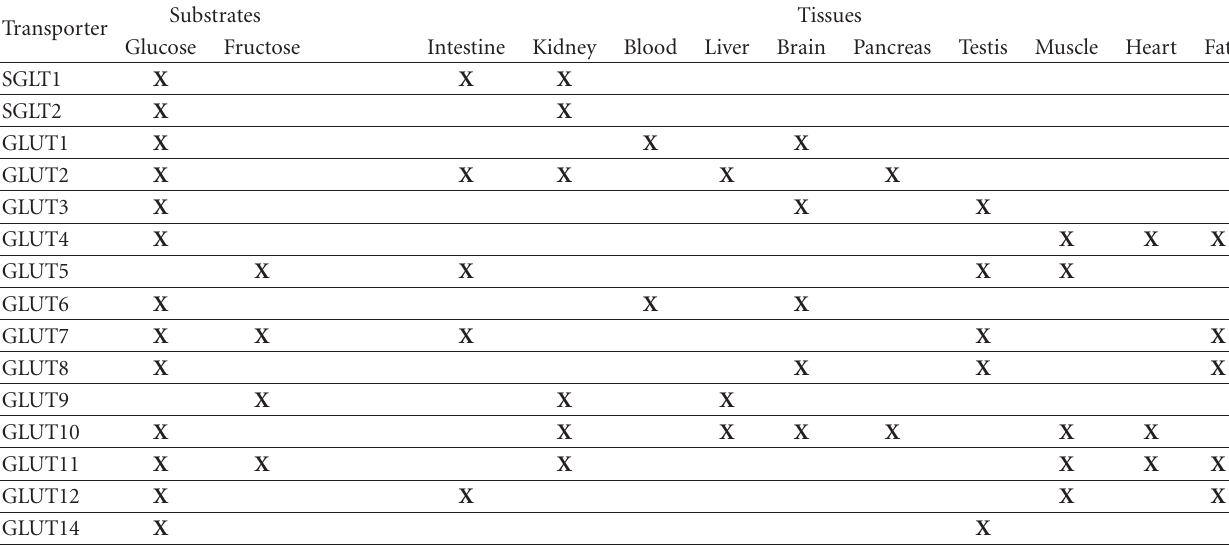
Table 1: Substrate specificity and tissue expression of sugar